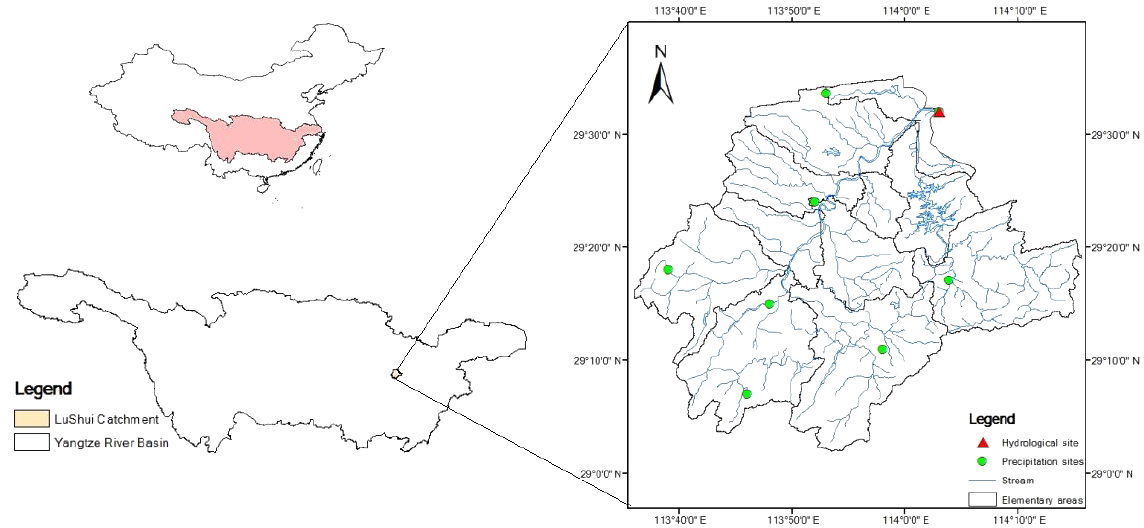
Figure 3. Lushui (LS) catchment. The red triangle is the ChongYang hydrological site that observes precipitation, pan evaporation and runoff; the green dots are precipitation sites set up to measure precipitation only; the blue line is the LS stream. The elementary areas are also shown, which are the computation unit of the XAJ models (see Sect. 2.1 for details). Table 2. Variable, MODIS product name, and spatial and temporal resolution of the remote sensing data used in this paper Remote sensing variable MODIS product name Spatial